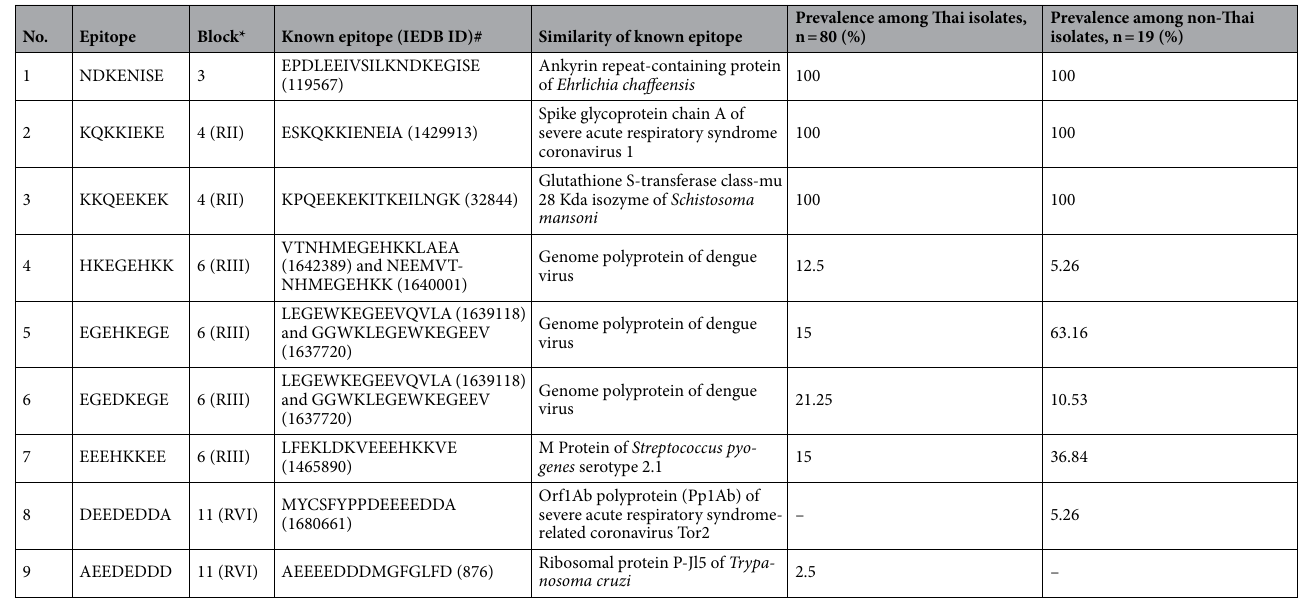
Table 8. Predicted linear B cell epitopes spanning 8 amino acids in PfGARP and their distribution among variant alleles. *After Fig. 1. # Immune epitope database and analysis resource identity